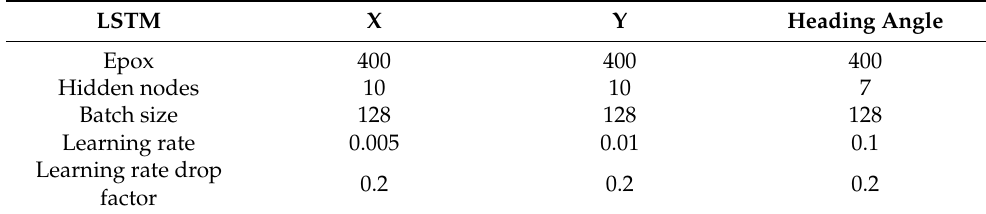
Table 2. LSTM and GRU model